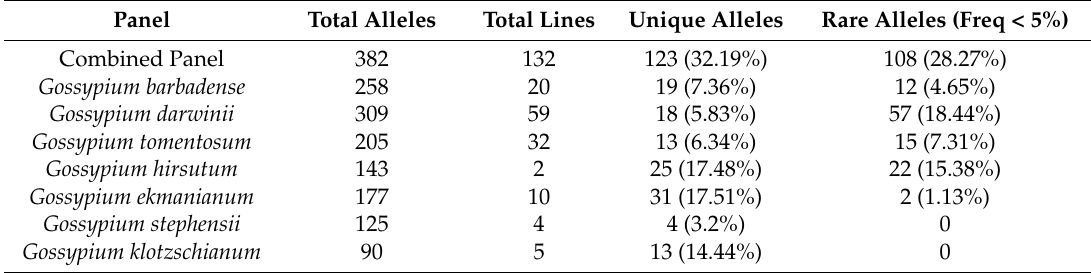
Table 1. Summary of unique (present in one accession) and rare alleles (present in <5% accessions) observed in a combined Panel of 132